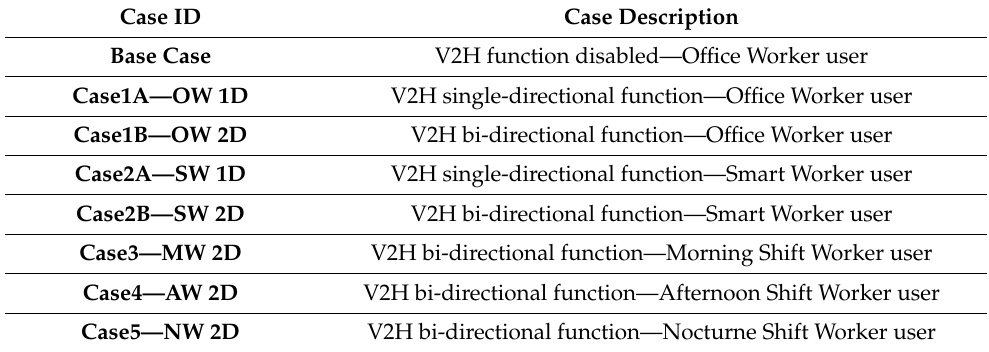
Table 1. Simulated